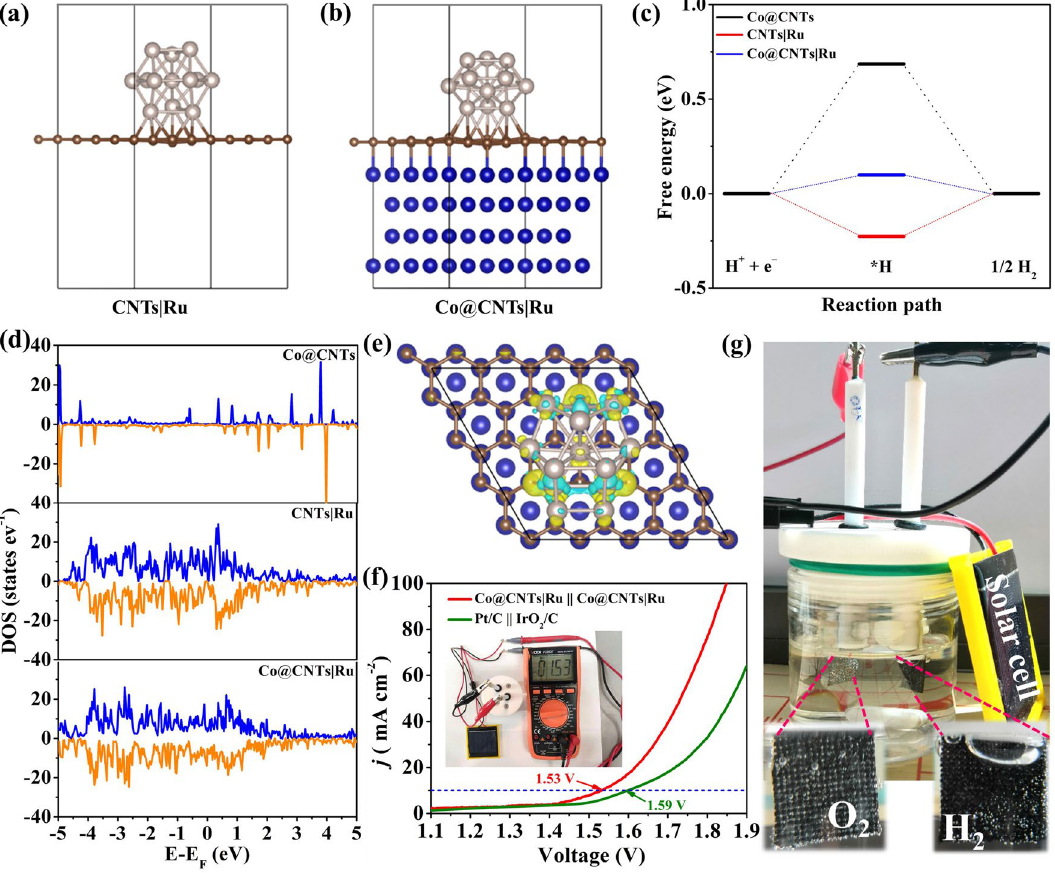
Fig. 6 Atomistic structures of the a CNTs|Ru and b Co@CNTs|Ru in HER process; c corresponding free-energy diagram of Δ G H* ; d DOS of Co@CNTs, CNTs|Ru and Co@CNTs|Ru system; e the charge density redistributions of Co@CNTs|Ru system (the blue, brown and white balls represent Co, C, and Ru atoms); f LSV curve of the typical two-electrode system by employing Co@CNTs|Ru as electrocatalysts; commercial Pt/C || IrO 2 /C was also tested for comparison (Inset: digital photograph of solar panel-assisted water splitting device); g the magnified photos of